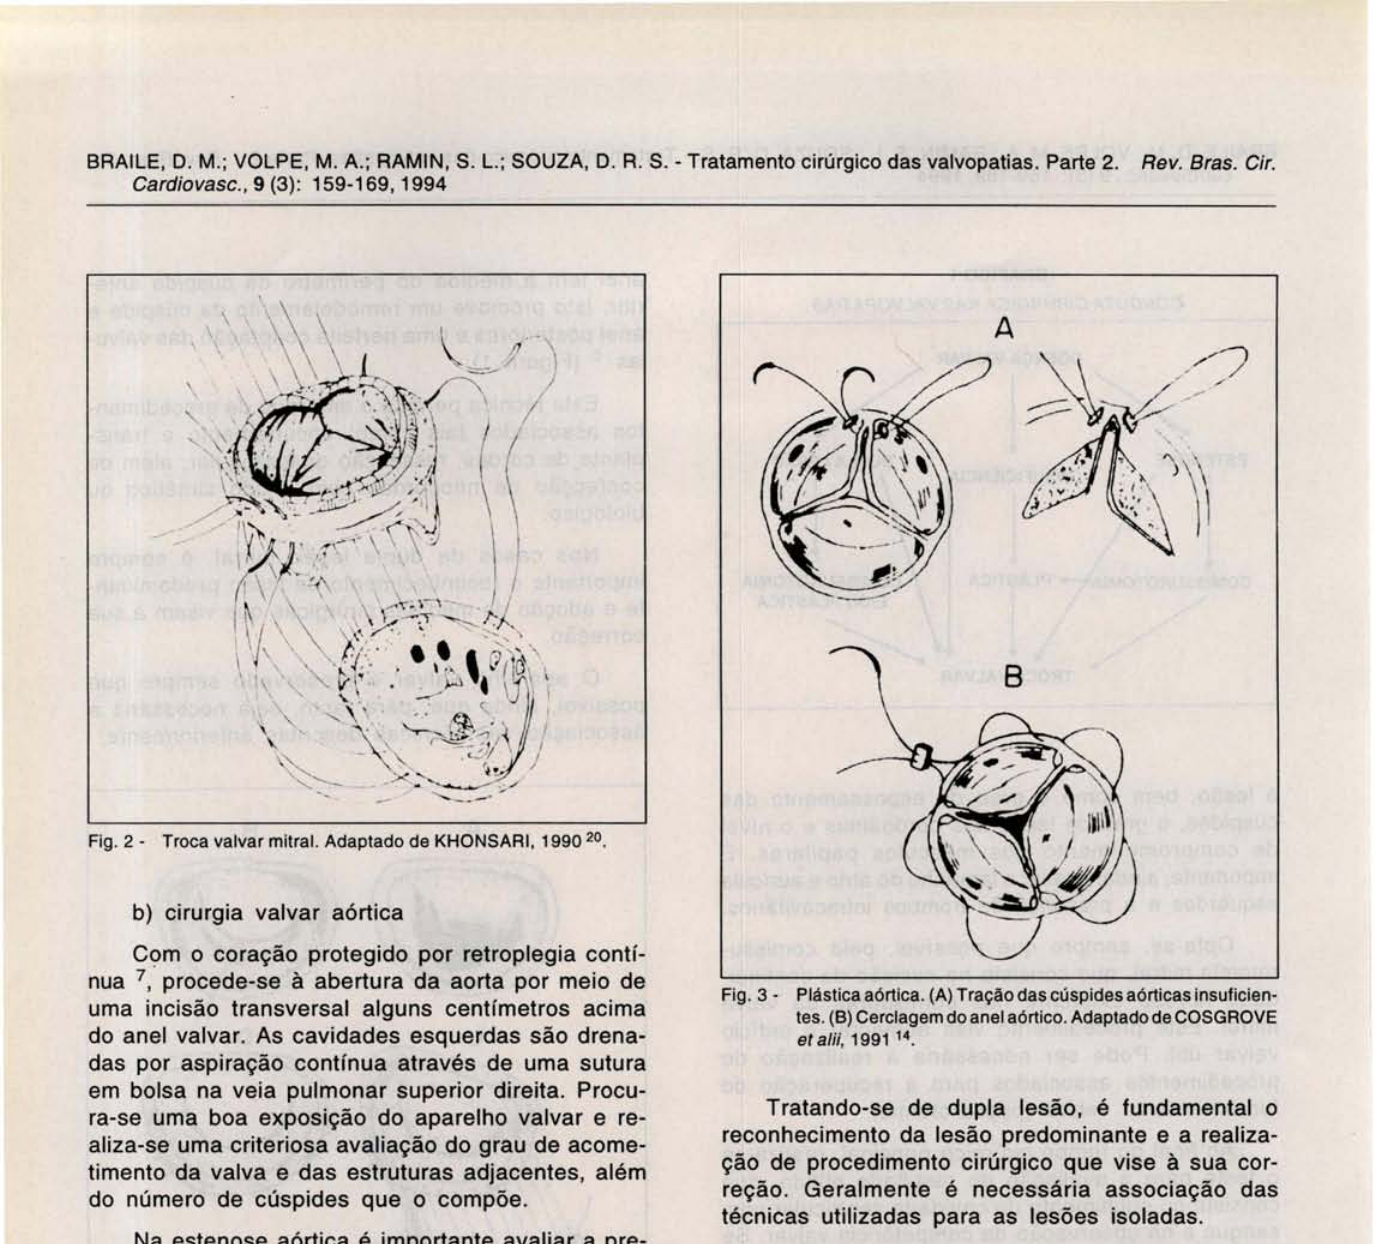
Fig. 2 - Troca valvar mitral. Adaptado de KHONSARI, 1990 2 b) cirurgia valvar aórtica